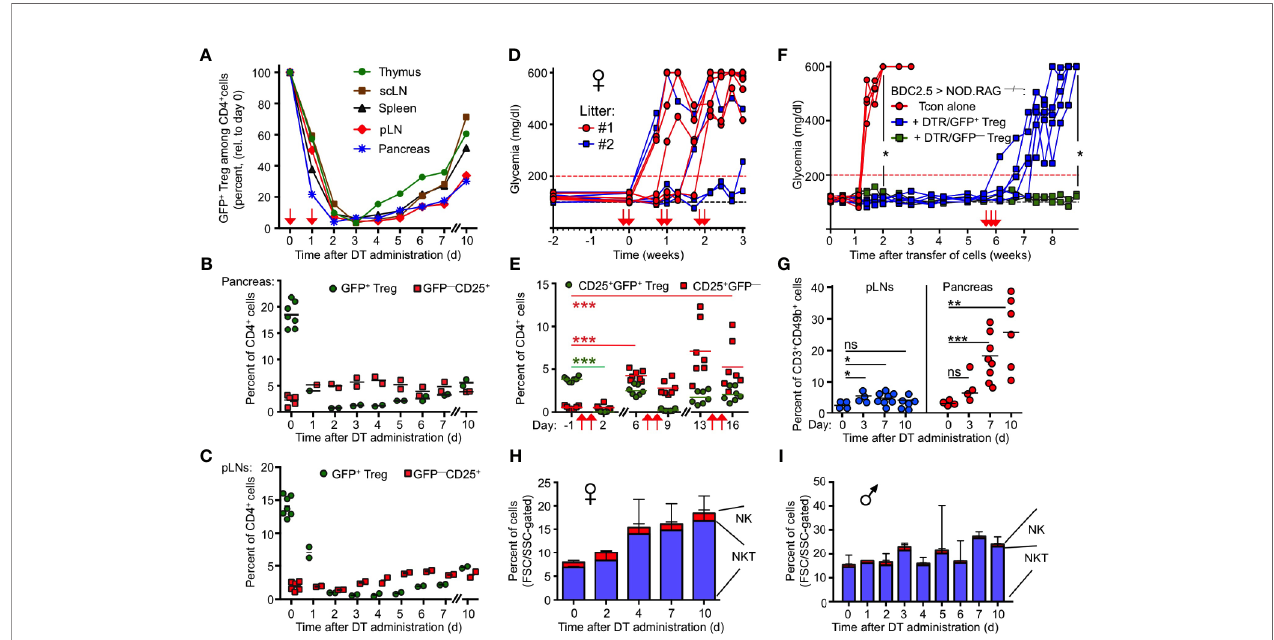
FIGURE 2 | Transient nature of Treg cell ablation in NOD.DEREG mice. (A) Kinetics of DT-mediated ablation and subsequent recovery of the CD4 + GFP + Treg cell compartment in pancreas and indicated lymphoid organs of 10-12-week-old NOD.DEREG mice. Data are from a single experiment (2 mice/timepoint) representative of 3 experiments performed. Arrows indicate days of DT injection. (B, C) GFP + Treg cell recovery in (B) pancreas and (C) pLN is preceded by the rapid accumulation of CD4 + CD25 + cells lacking DTR/GFP expression (GFP – ). Each symbol corresponds to an individual mouse (10-12-week-old). (D, E) Impact of repeated DT administration on glycemic state and Treg cell depletion. (D) Blood glucose concentrations of individual NOD.DEREG mice presented in Figure 1 (H) . Arrows indicate days of DT injection. (E) Kinetics of CD25 + GFP + and CD25 + GFP – cells among CD4-gated cells, as revealed by fl ow cytometry among peripheral blood- derived CD4 + T cells at different timepoints (Two-way ANOVA in combination with Bonferroni ’ s Multiple Comparison post-test: ***p < 0.001). (F) Acute Treg cell ablation in the absence of Treg cell rebound. NOD.RAG1 – / – mice were repopulated with diabetogenic BDC2.5 T conventional cells, either alone (red circles) or with GFP + (blue squares) or DTR/GFP – (green squares) Treg cells, and blood glucose levels of recipients were routinely assessed at least twice a week for up to 9 weeks. DT was injected at three consecutive days of week 6 (arrows). (Mann-Whitney-U test; two weeks: p = 0.0159, nine weeks: p = 0.0476). (G – I) Pancreatic NKT cell accumulation after Treg cell ablation. (G) Percentages of CD3 + CD49b + NKT cells among FSC/SSC-gated cells in pLNs (left) and pancreas (right) of 12-16-week-old NOD.DEREG females before (day 0) and at indicated days after DT administration. Symbols and horizontal lines indicate individual mice (4-8 mice per timepoint) and mean values, respectively. Unpaired t-test: ns, not signi fi cant; *p ≤ 0.05, **p ≤ 0.01, ***p < 0.001). (H, I) Kinetics of pancreas-in fi ltrating CD3 + CD49b + NKT and CD3 – CD49b + NK cells (FSC/SSC-gated) in (H) female and (I) male NOD.DEREG mice (10-12-week-old). Shown are mean percentages ± SD (day 0: n = 7) or mean percentages and range of replicate mice (days 1-7, day 10: n =